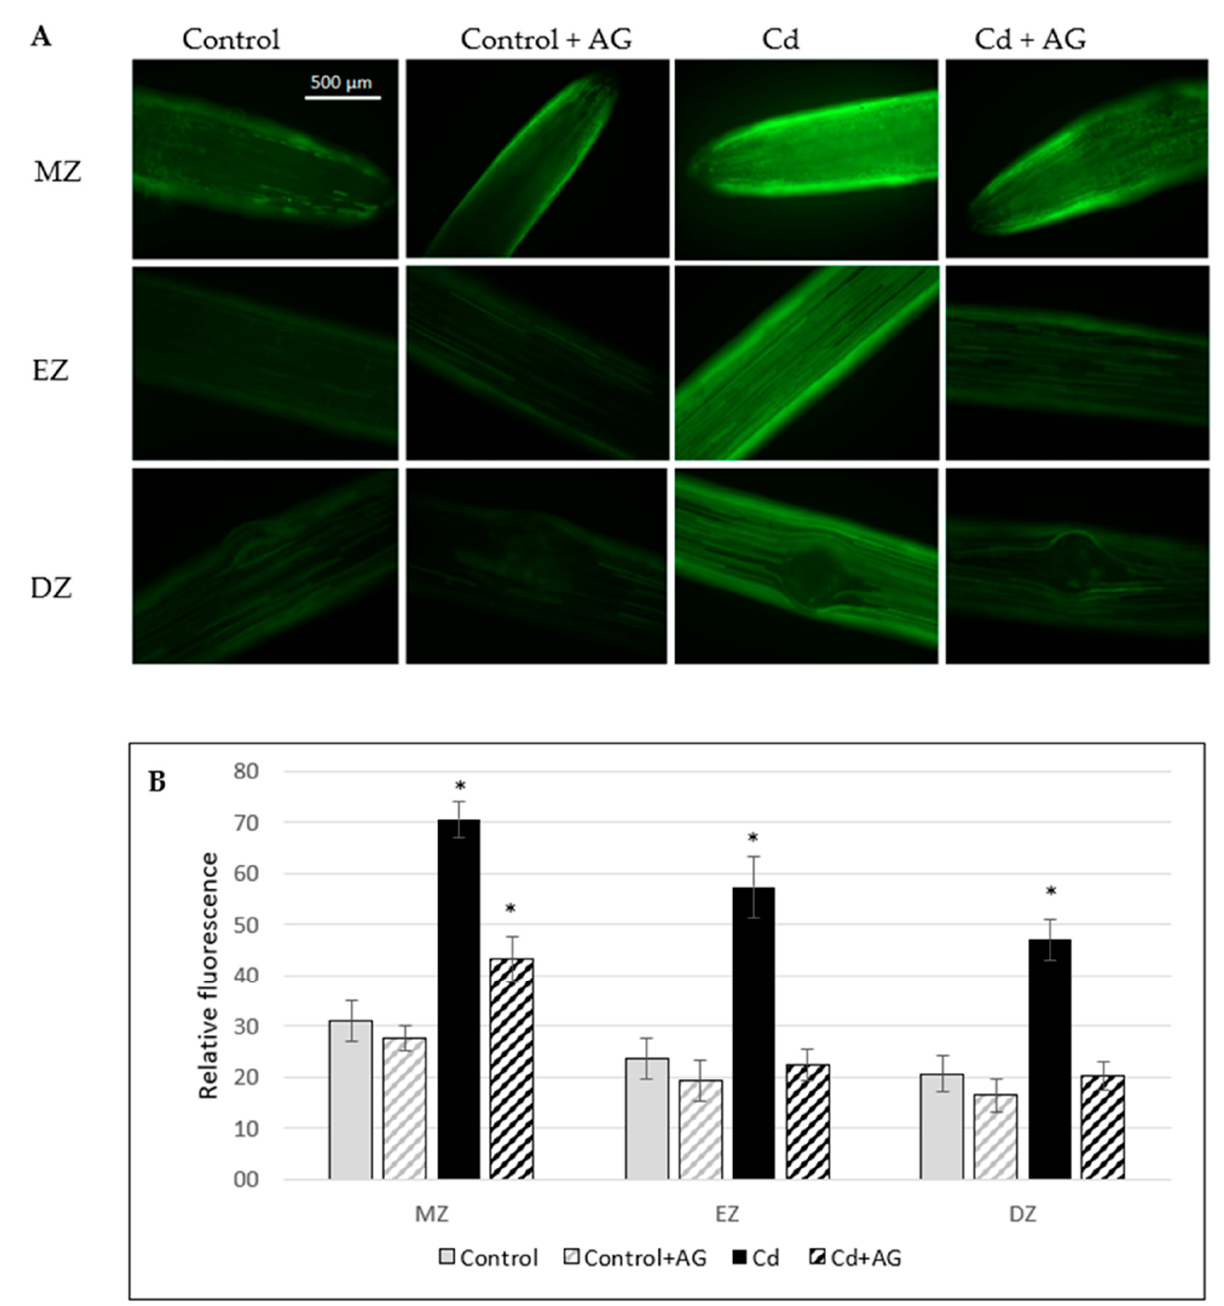
Figure 5. Bio-imaging of NO level in the roots of cucumber seedlings treated with Cd in the presence or absence of aminoguanidyne (AG) ( A ) and the mean related fluorescence density ± SD ( B ). After 3 days of treatment with Cd, plants were transferred to the control conditions for another 3 days (Cd) or to the control nutrient solutions with aminoguanidyne (Cd + AG). At the same time, control plants were also treated with aminoguanidyne (control + AG). NO production was monitored by labeling with the NO-specific fluorescent dye DAF-2D and imaged using fluorescent microscopy. The images are representative for at least three roots for each treatment from three independent replications of the experiment. Asterisks on the figure indicate significant differences (* p < 0.05). The intensity of green fluorescence in the images was analyzed and expressed as the average number of pixels in green channel on a scale ranging from 0 to 255. MZ—meristematic zone, EZ—elongation zone, DZ—differentiation zone.